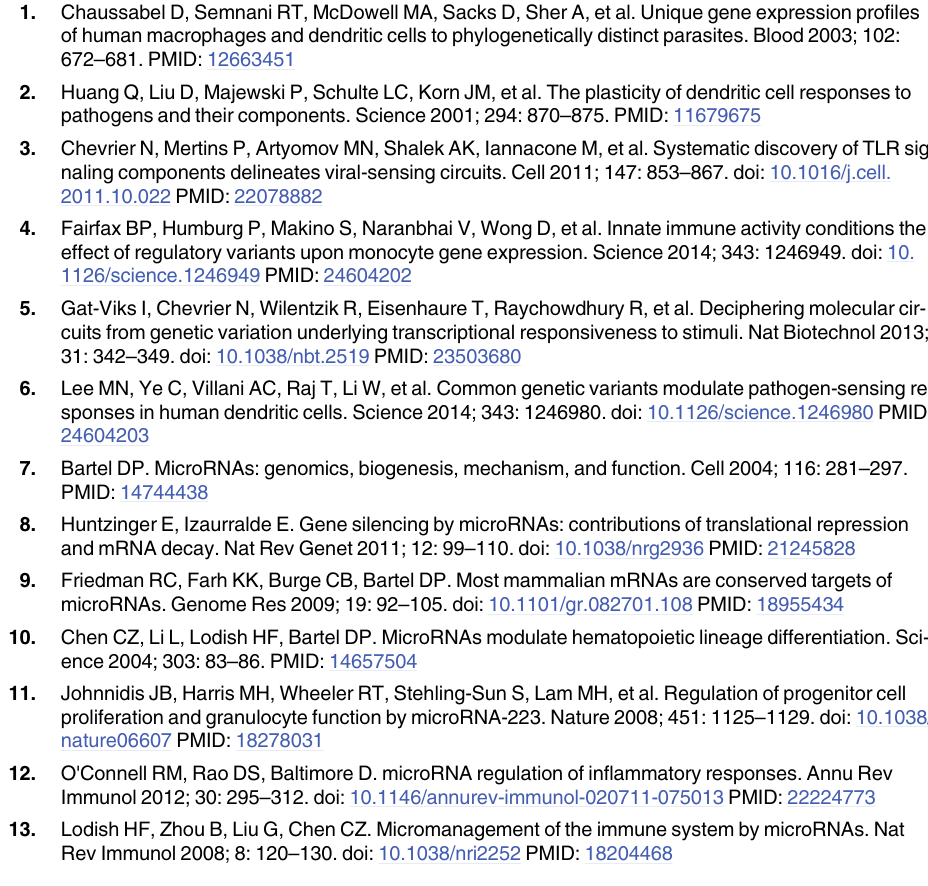
S8 Table. List of expressed isomiRs with p-values and fold-changes of their differential ex- pression upon infection compared to non-infected samples. S9 Table. List of expressed miRNAs with p-values and D duced changes in isomiR distribution. S10 Table. List of the dominant isomiR in each experimental